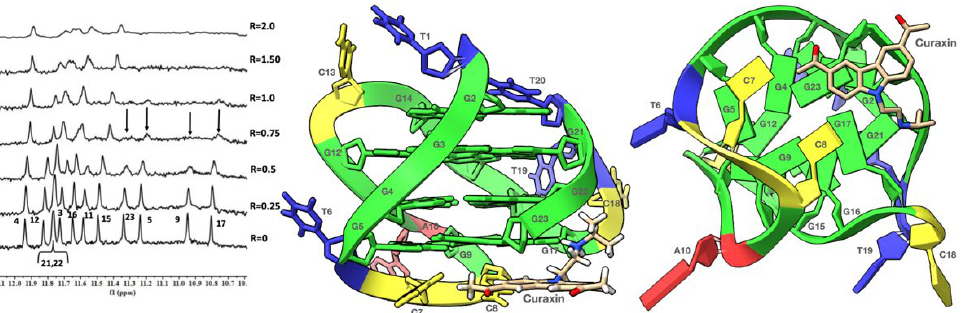
Figure 3 . Imino proton region of the 1D NMR titration spectra of TP3-T6 with curaxin (Left), recorded at 25 °C and different R = (drug)/(DNA) ratios. The side (Center) and 3 ′ -end (Right) views of the TP3-T6/curaxin complex obtained by Molecular Docking were created by using the Chimera-X software. In the side (Center) view, nucleotides are shown in sticks to reveal atoms and bonds, while in the 3 ’ -end (Right) view the nucleotides are shown as slabs and filled sugars: Adenine in red, Cytosine in yellow, Guanine in green and Thymine in blue. The curaxin molecule is rendered in sticks and colored according to the atoms.